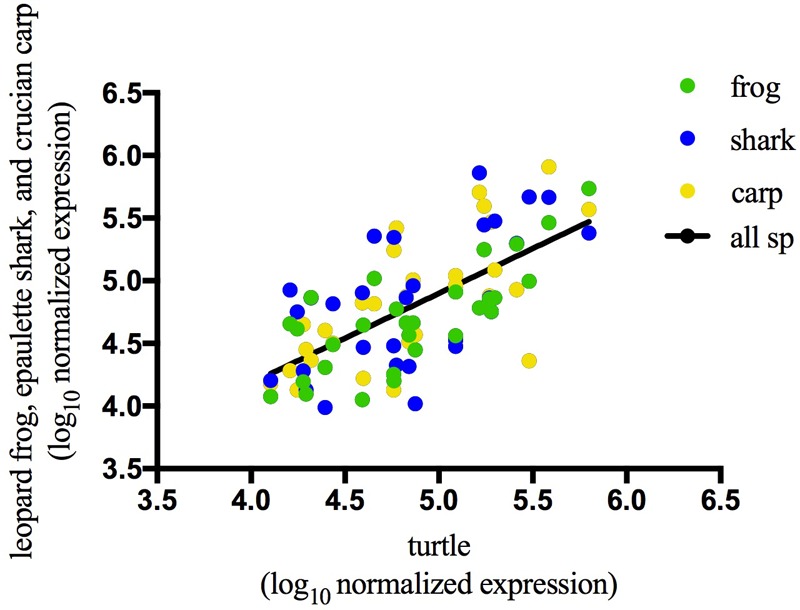
Correlation of normoxic expression values for the 29 sequences shared among the top 100 sequences from all 4 species. Log10 normalized expression values of top 100 most abundant small ncRNA sequences during normoxia are positively correlated with expression values of identical sequences in turtle during normoxia. R2 = 0.4494, p < 0.0001. See Table 3 for correlations between all other pairs of species.